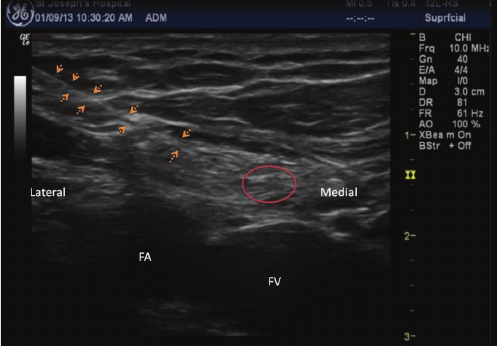
Figure 3: Injection into the inguinal canal to block the gen- itofemoral